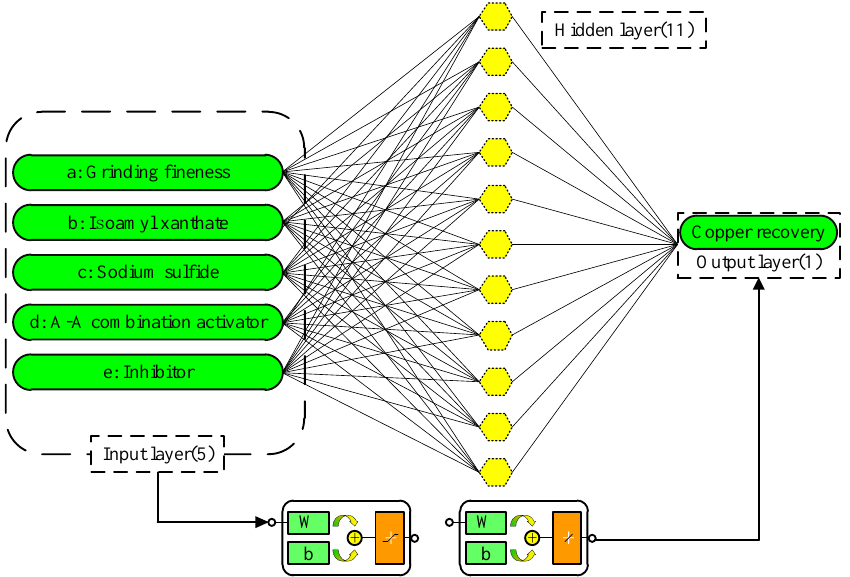
Figure 10. Flow chart of the back propagation (BP) neural network model.